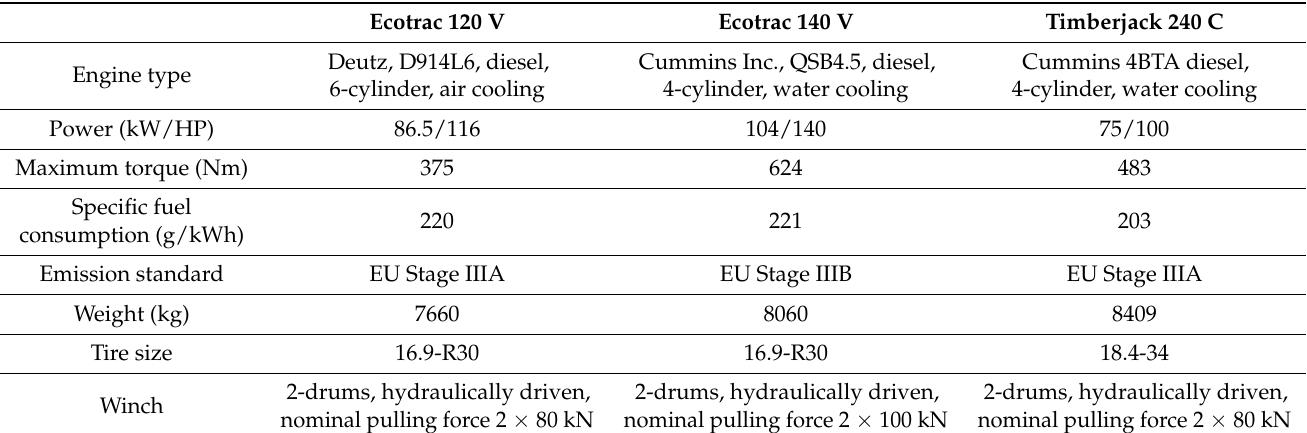
Table 1. Technical characteristics of researched skidders.